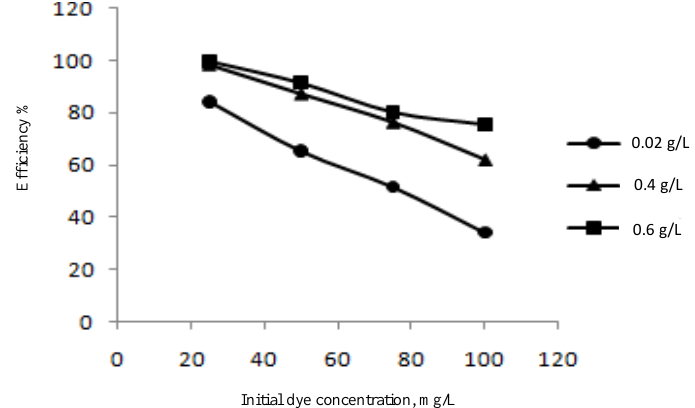
Figure 7. Effect of initial dye concentration on adsorption of AR18 onto MWCNT time = 120 min, pH = 3, T =25 o